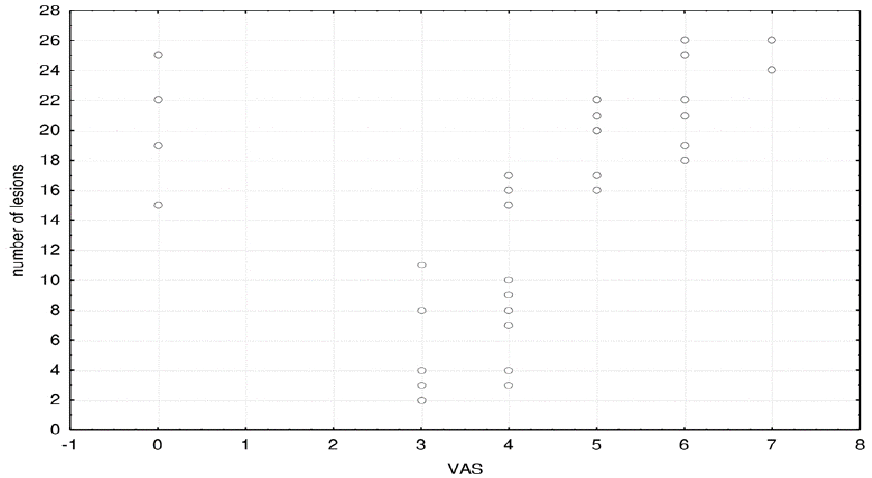
Figure 6. Scatter plot of the correlation between the number of brain lesions with the degree of VAS. The number of brain lesions significantly correlated with the VAS degree of headache: Spearman correlation coefficient rho = 0.578 ( p <